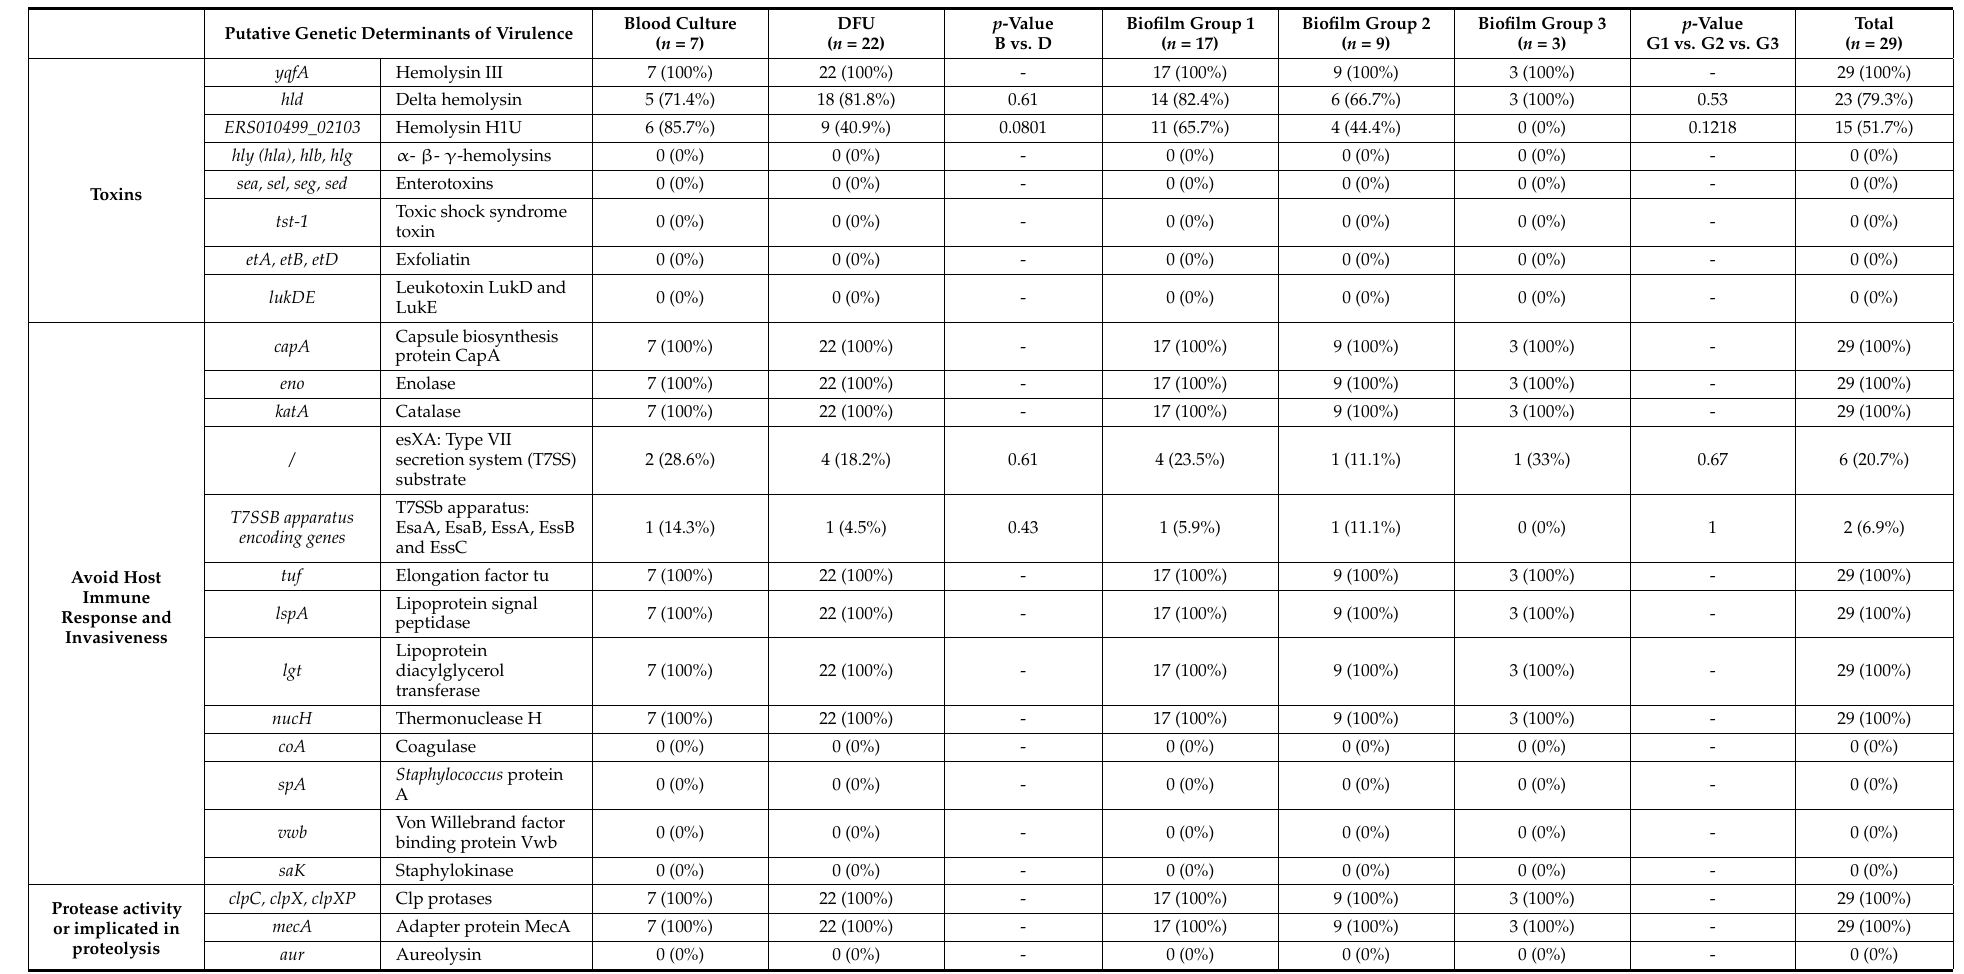
Table 4. Comparison of virulence-related genes between S. pettenkoferi isolated from blood cultures and infected DFUs and their biofilm group